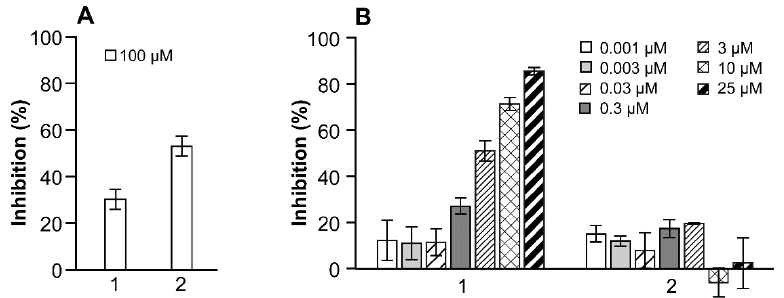
Figure 7. Inhibition by compounds 1 and 2 of the transformation of estradiol (E2) into estrone (E1) by recombinant 17 β -hydroxysteroid dehydrogenase type 10 (17 β -HSD10) ( A ) and HEK-293[17 β - HSD10] intact cells ( B ). Results of a triplicate expressed in % ±